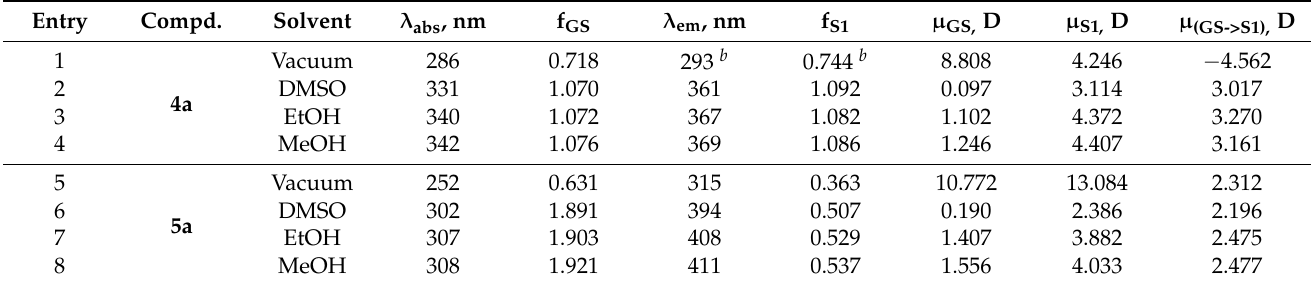
Table 6. Calculated absorption and emission properties of 4a and 5a in vacuo, DMSO, EtOH, and MeOH a .